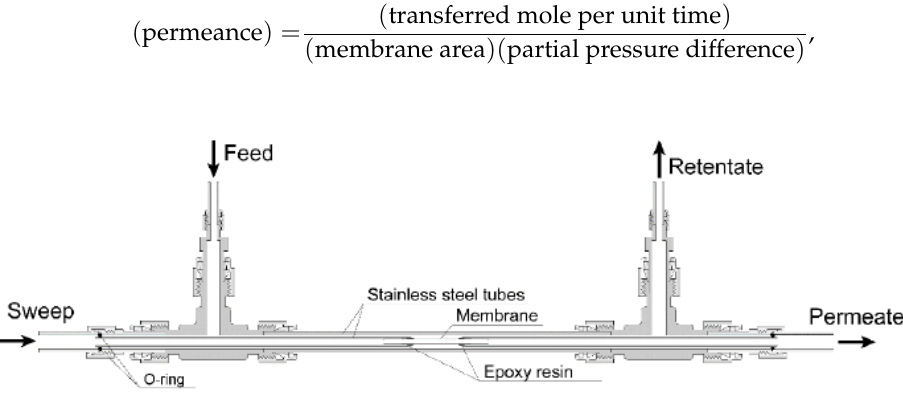
Figure 2. Schematic illustration of the permeation cell. The separation factor was defined as the ratio of permeances in this study